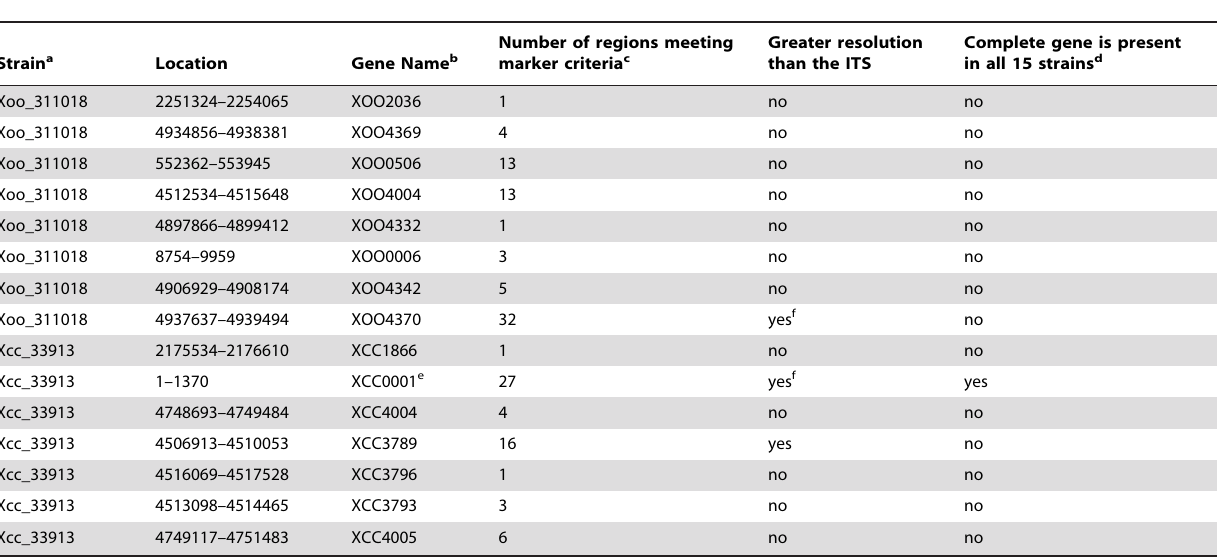
Table 2. Genes in Xoo_311018 and Xcc_33913 containing regions that match criteria for potential markers.